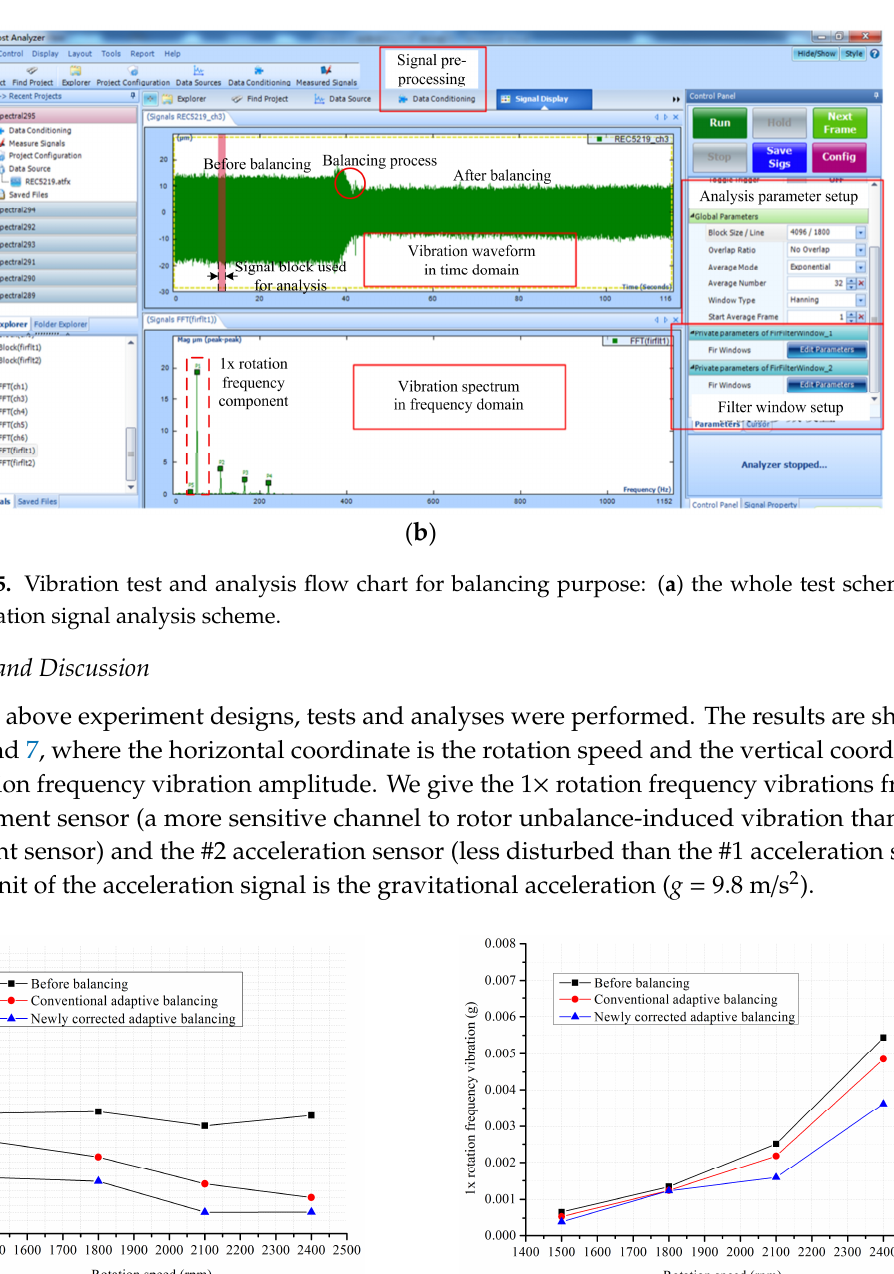
Figure 5. Vibration test and analysis flow chart for balancing purpose: ( a ) the whole test scheme; ( b ) vibration signal analysis scheme.